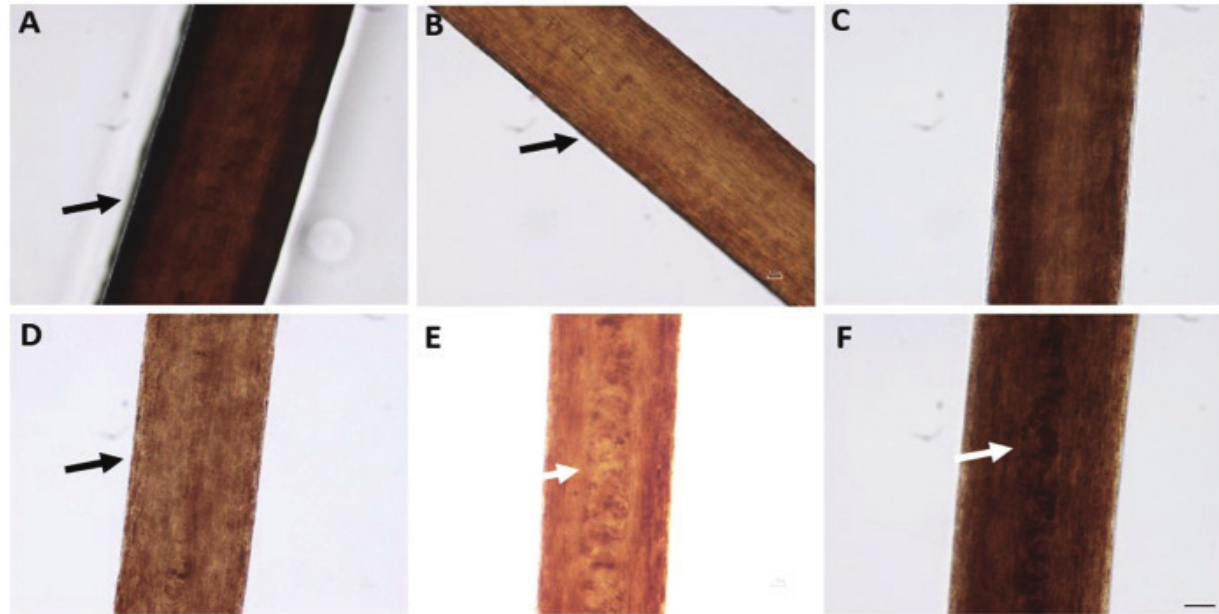
Figure-III: Representative images of qualitative parameters in the cortex, medulla and cuticle of hair in non-Factory workers (HH). Scale 20 micron. Black arrow Cuticle, White arrow Medulla.